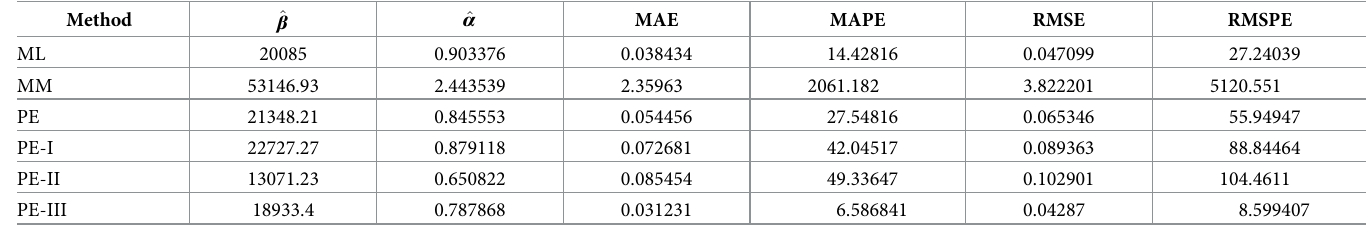
Table 5. Comparison of estimators for example 1.